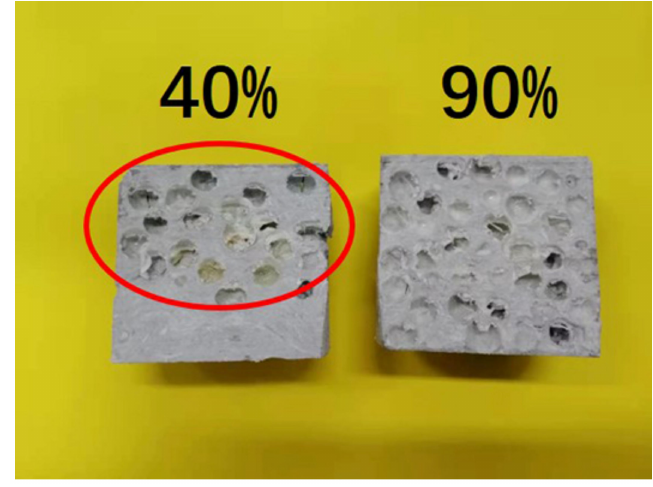
Figure 8. The longitudinal section of the